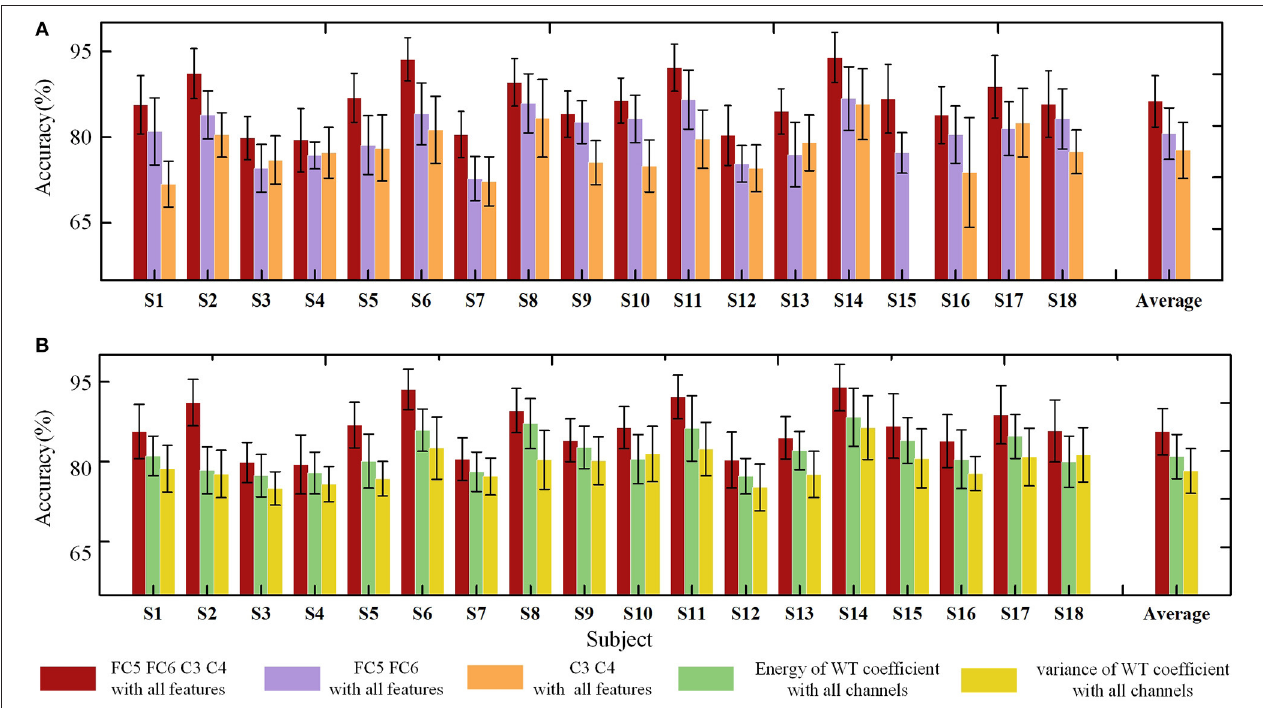
FIGURE 6 | Offline classification accuracies of standard deviations using two analyses for each subject. (A) Offline accuracies of three channel conditions: FC5, FC6, C3, C4 vs. FC5, FC6 vs. C3, C4. The red bar indicates the accuracies based on the proposed method, the violet bar indicates the accuracies based on the FC5 and FC6 channels, and the orange bar denotes the accuracies based on the C3 and C4 channels. (B) Offline accuracies of three feature set conditions: energy of the WT coefficient vs variance of the WT coefficient vs the combination of these features. The red bar indicates the accuracies based on the proposed method, the green bar indicates the accuracies based on the energy of the WT coefficient, and the yellow bar denotes the accuracies based on the variance of the WT